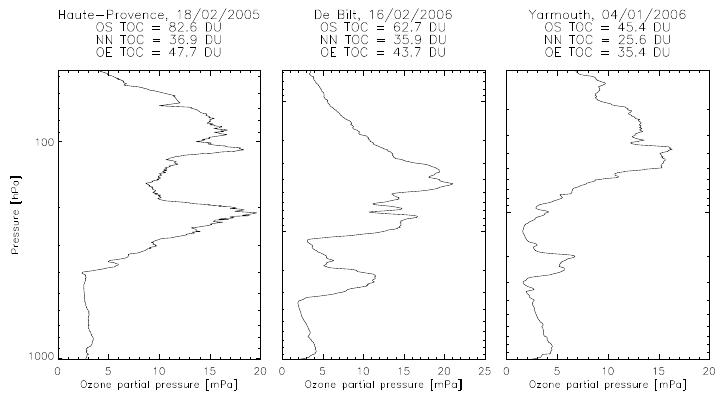
Fig. 10. OS concentration profiles at Haute-Provence, France, for 18 February 2005; De Bilt, the Netherlands, for 16 February 2006; Yarmouth, Canada, for 4 January 2006. TOC values from OS, NN and OE are also given.